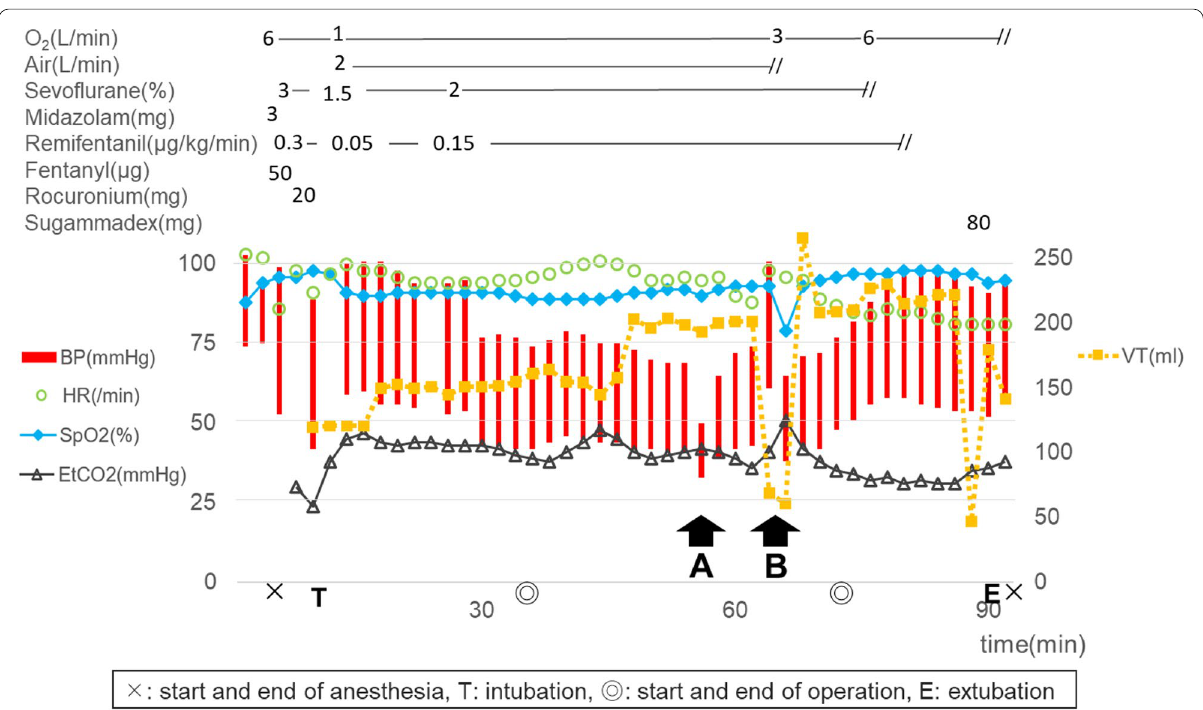
Fig. 1 Anesthesia record. An abrupt decrease of blood pressure ( A ), tidal volume, and SpO 2 ( B ) occurred corresponding to the timing of inflation of the balloon at the tip of the endoscope and injection of the sclerosing agents into the varicose veins in gastric cardia ( A ) and in the esophagus ( B ), respectively. BP: blood pressure, HR: heart rate, VT: tidal volume